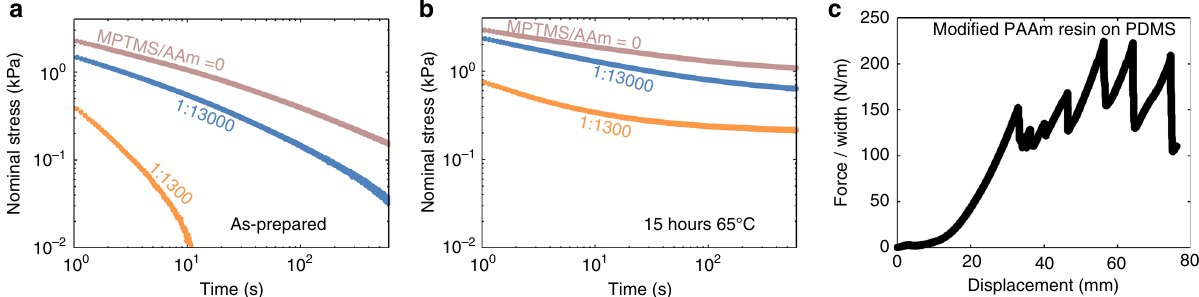
Fig. 6 Oxygen-tolerant hydrogel resin that bonds with silane-modi fi ed elastomer resin. a Stress relaxation tests show that as the average chain length decreases by adding chain transfer agent, the stress relaxation becomes faster. b After 12 h at 65 °C, the polymers are crosslinked into a network by the condensation of silanol groups. Consequently, the sample can hold stress without relaxing. c Oxygen-tolerant resin allows uncured PAAm resin and uncured PDMS resin to be layered, cured together, and form robust bonding